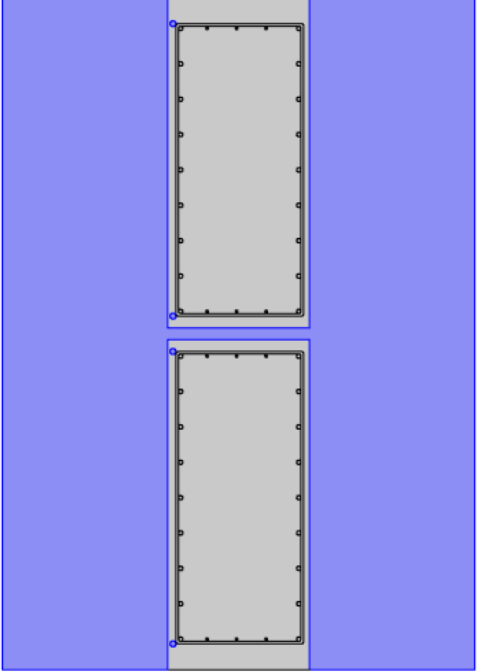
Figure 20. Non-isothermal flow interface.